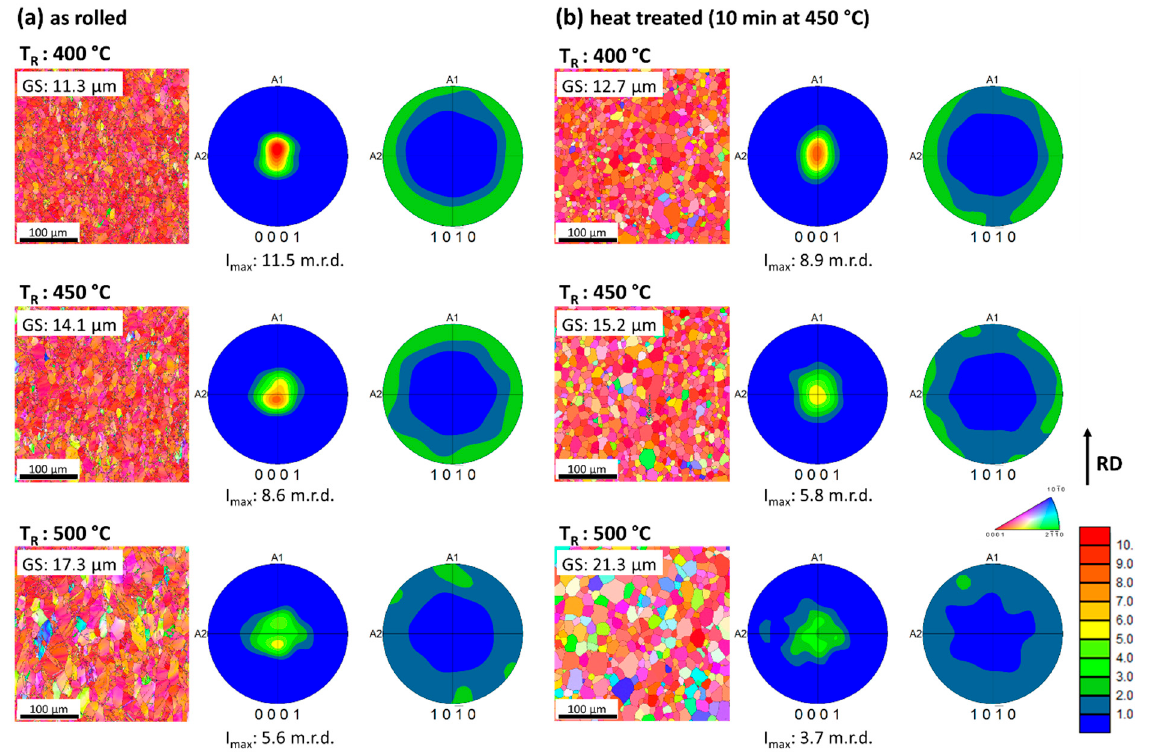
Figure 1. Inverse pole figure maps of AZ31 sheet ( a ) as-rolled, ( b ) after heat treatment for 10 min at 450 °C.